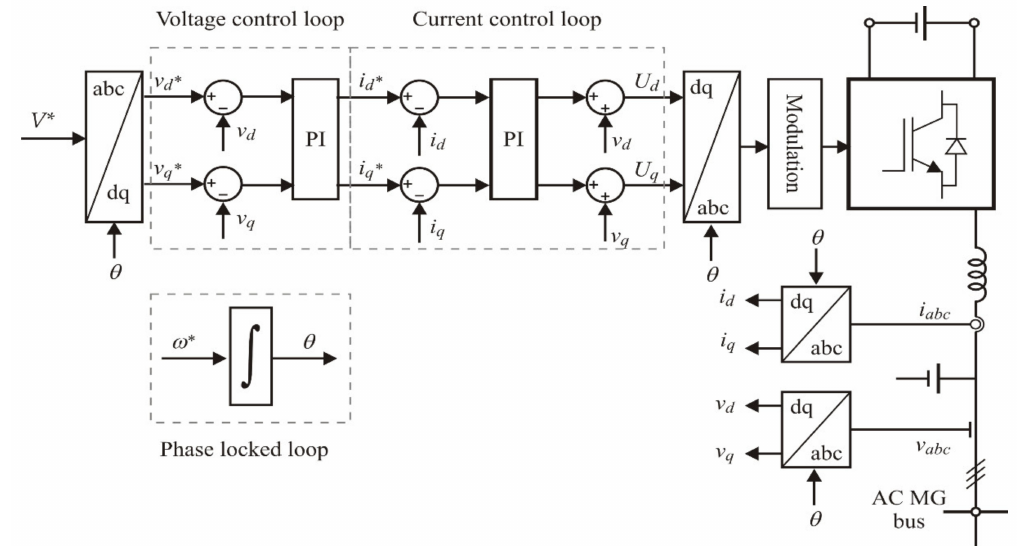
Figure 2. Grid-forming base control scheme (adapted from